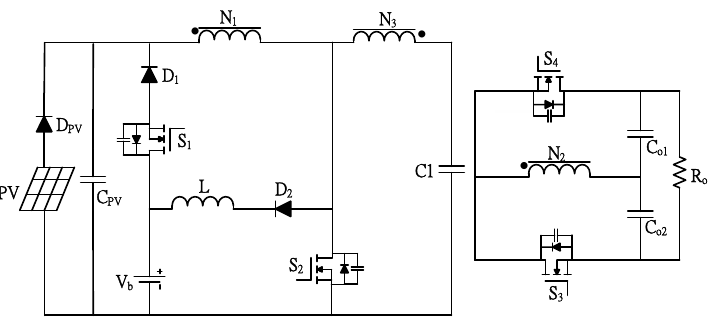
Figure 2. Novel three-port bidirectional converter with three-winding coupled inductors.